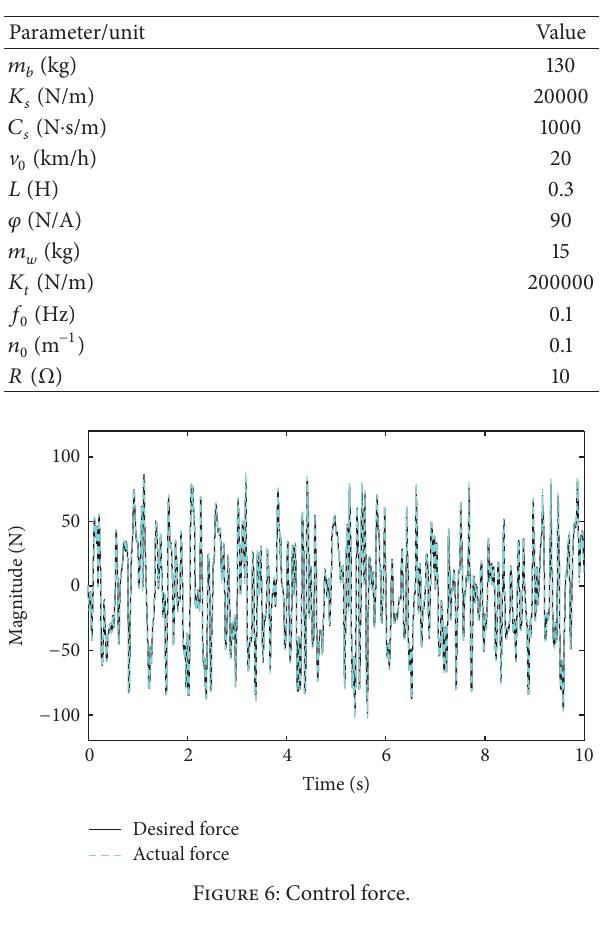
Table 2: Main parameters of the simulation.